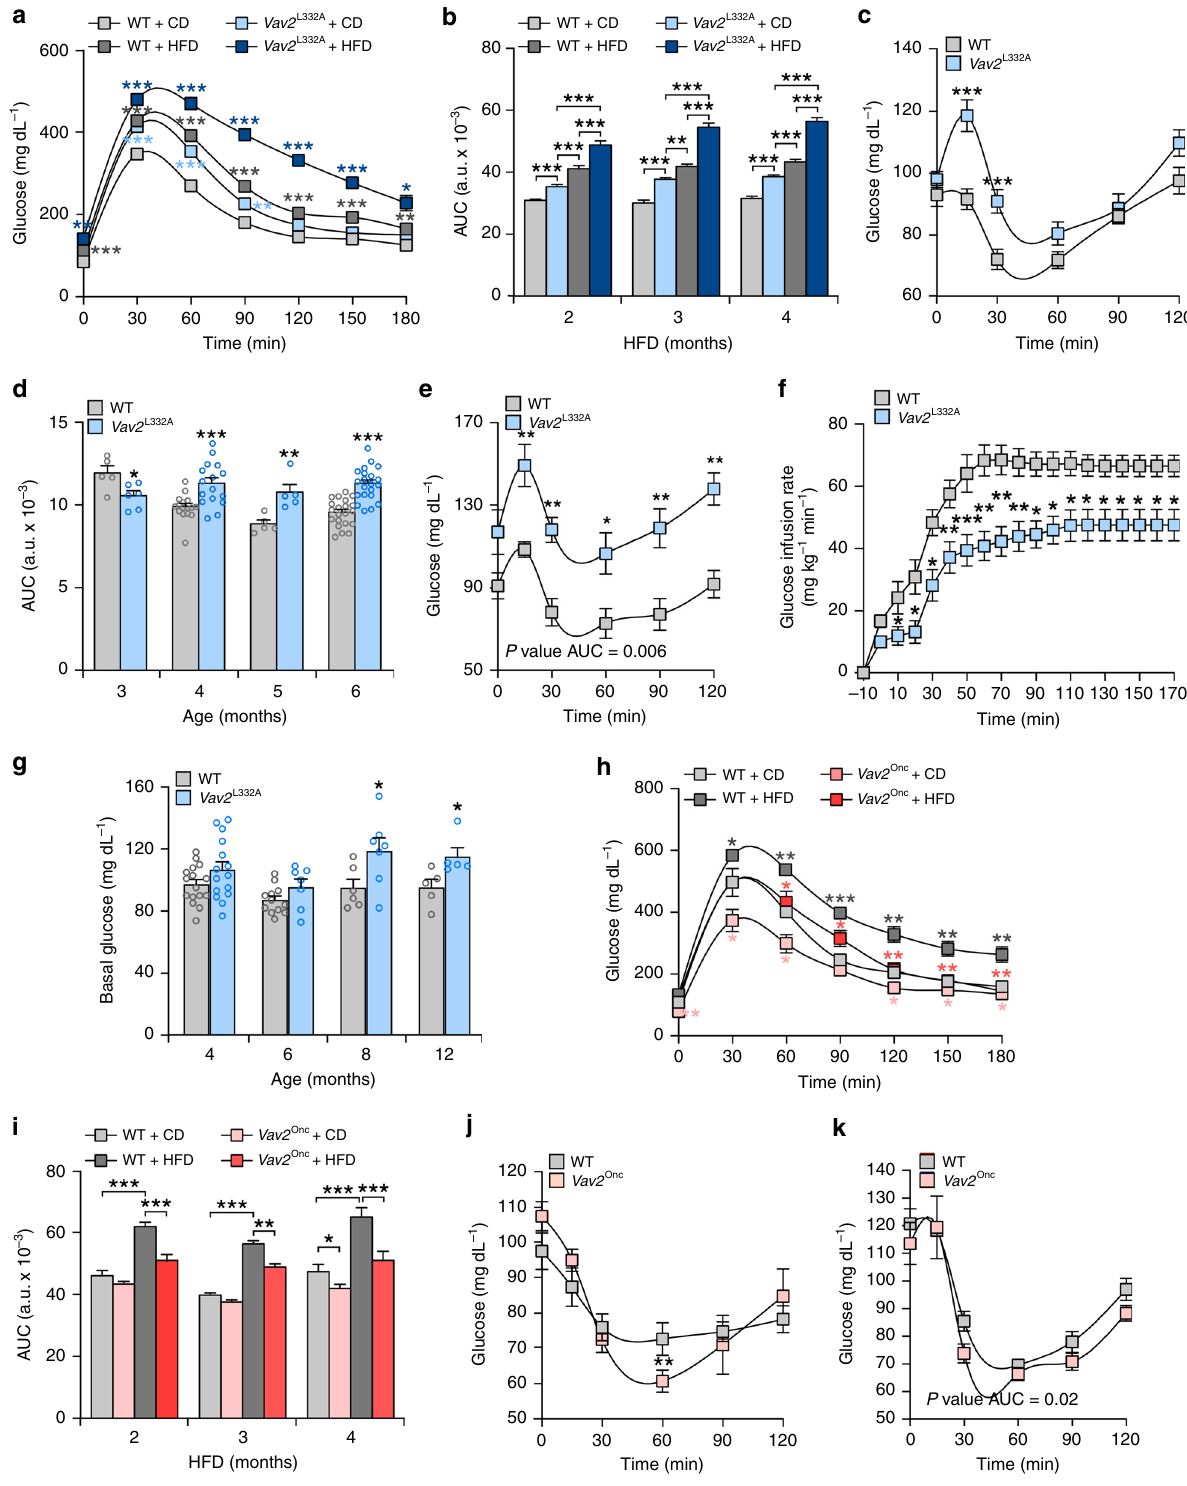
Vav2 Onc/Onc mice display the opposite phenotype in BAT under the two diet conditions examined (Fig. 10h – n). As in the former case, we could not observe any signi fi cant alteration in basal consumption rates (Supplementary Fig. 17b) and mito- chondrial content (Supplementary Fig. 17c) in young animals. Their thermogenic response to low temperature exposure is also similar to that found in controls (Supplementary Fig. 17d). The kinetics of these alterations are also similar to those found